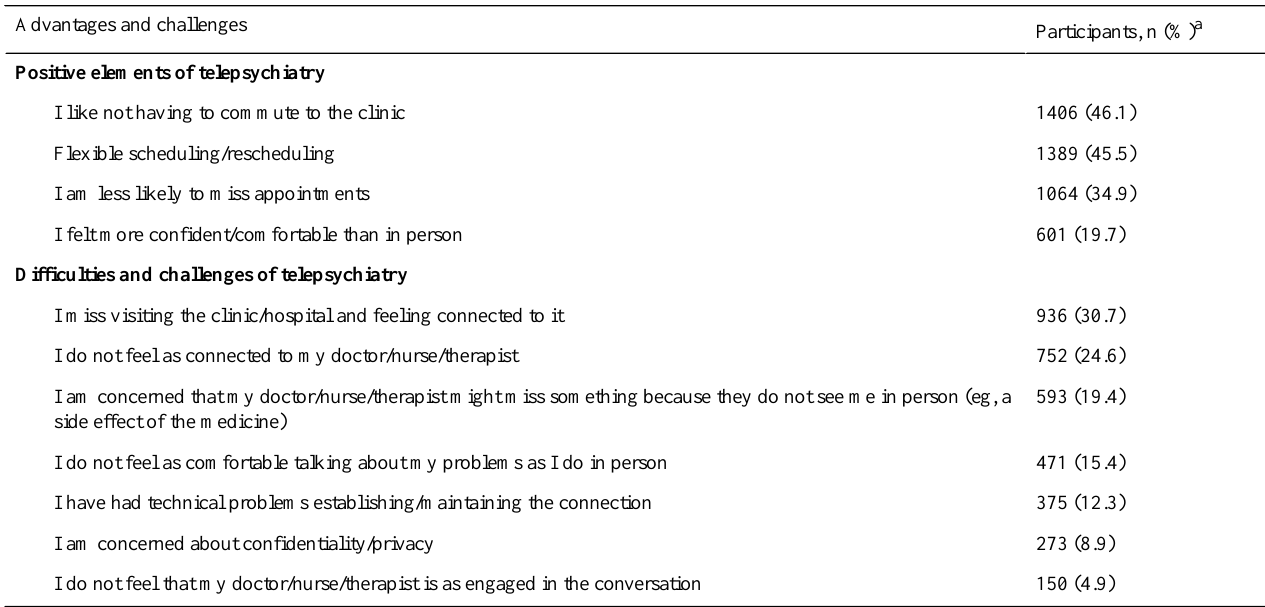
Participants, n (%) a Advantages and challenges